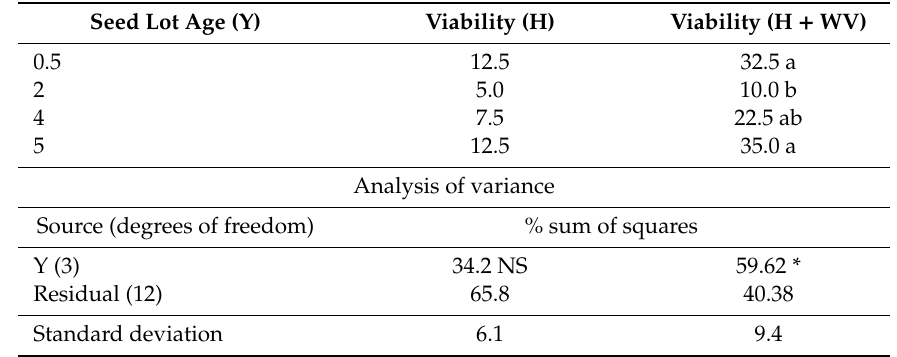
Mean values followed by di ff erent lower-case letters in each column indicate significant di ff erences at p ≤ 0.05 using the Fisher’s least significance di ff erence (LSD) test. * Indicates significant di ff erences at p ≤ 0.05. NS indicates not significant di ff